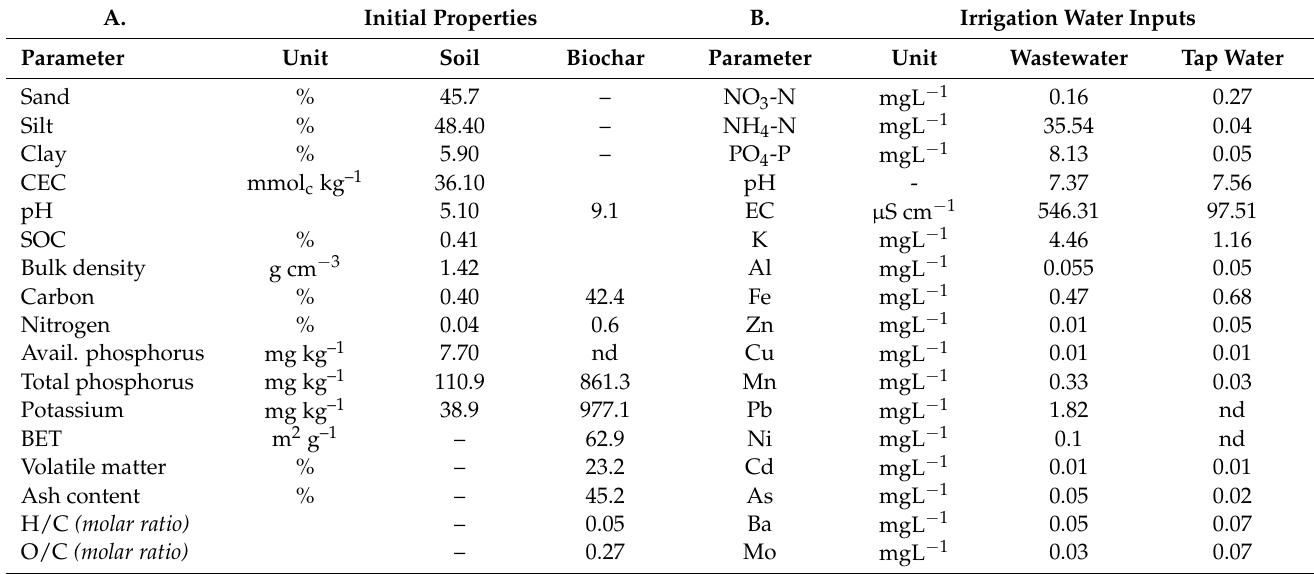
Table 1. Initial properties of biochar and soil (A) and average concentration ( n = 20) of nutrients and trace elements (B) in irrigation water inputs (adopted from [4,19]). ND represents not-detected.